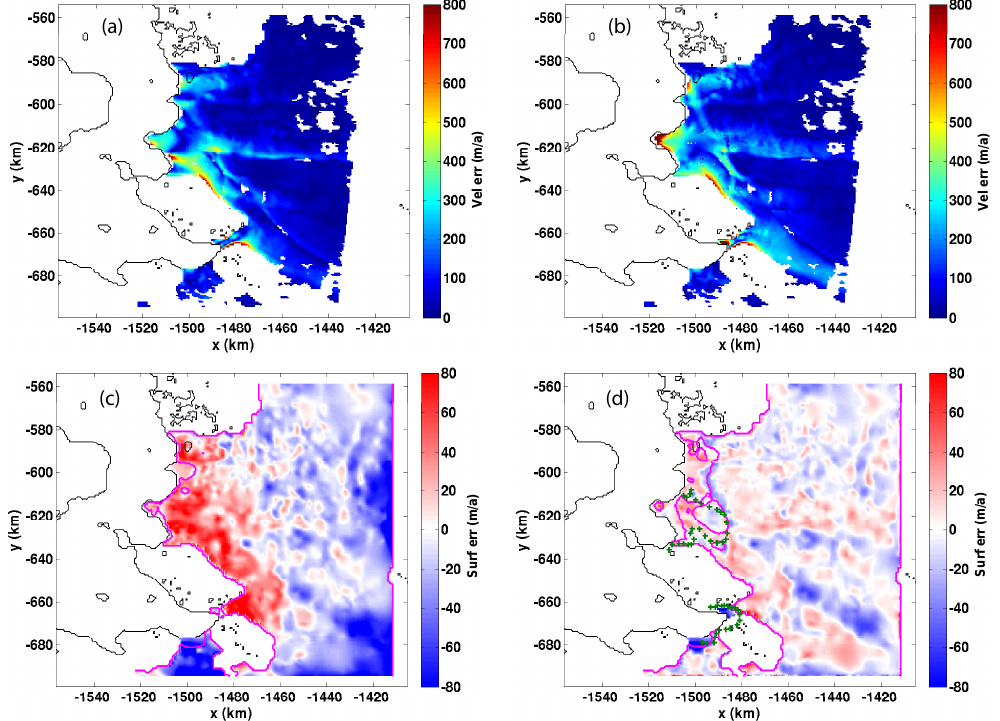
Figure 2. Difference between (top panels) modeled and observed velocities in 2010 (the last year available) and (bottom panels) modeled and observed surface elevation in 2011. Left panels: snapshot calibration. Right panels: transient calibration. The magenta contours represent modeled grounding lines in 2011. In (d) , the green hatches give the 2011 grounding line position reported by Rignot et al. (2014) (digitized from the